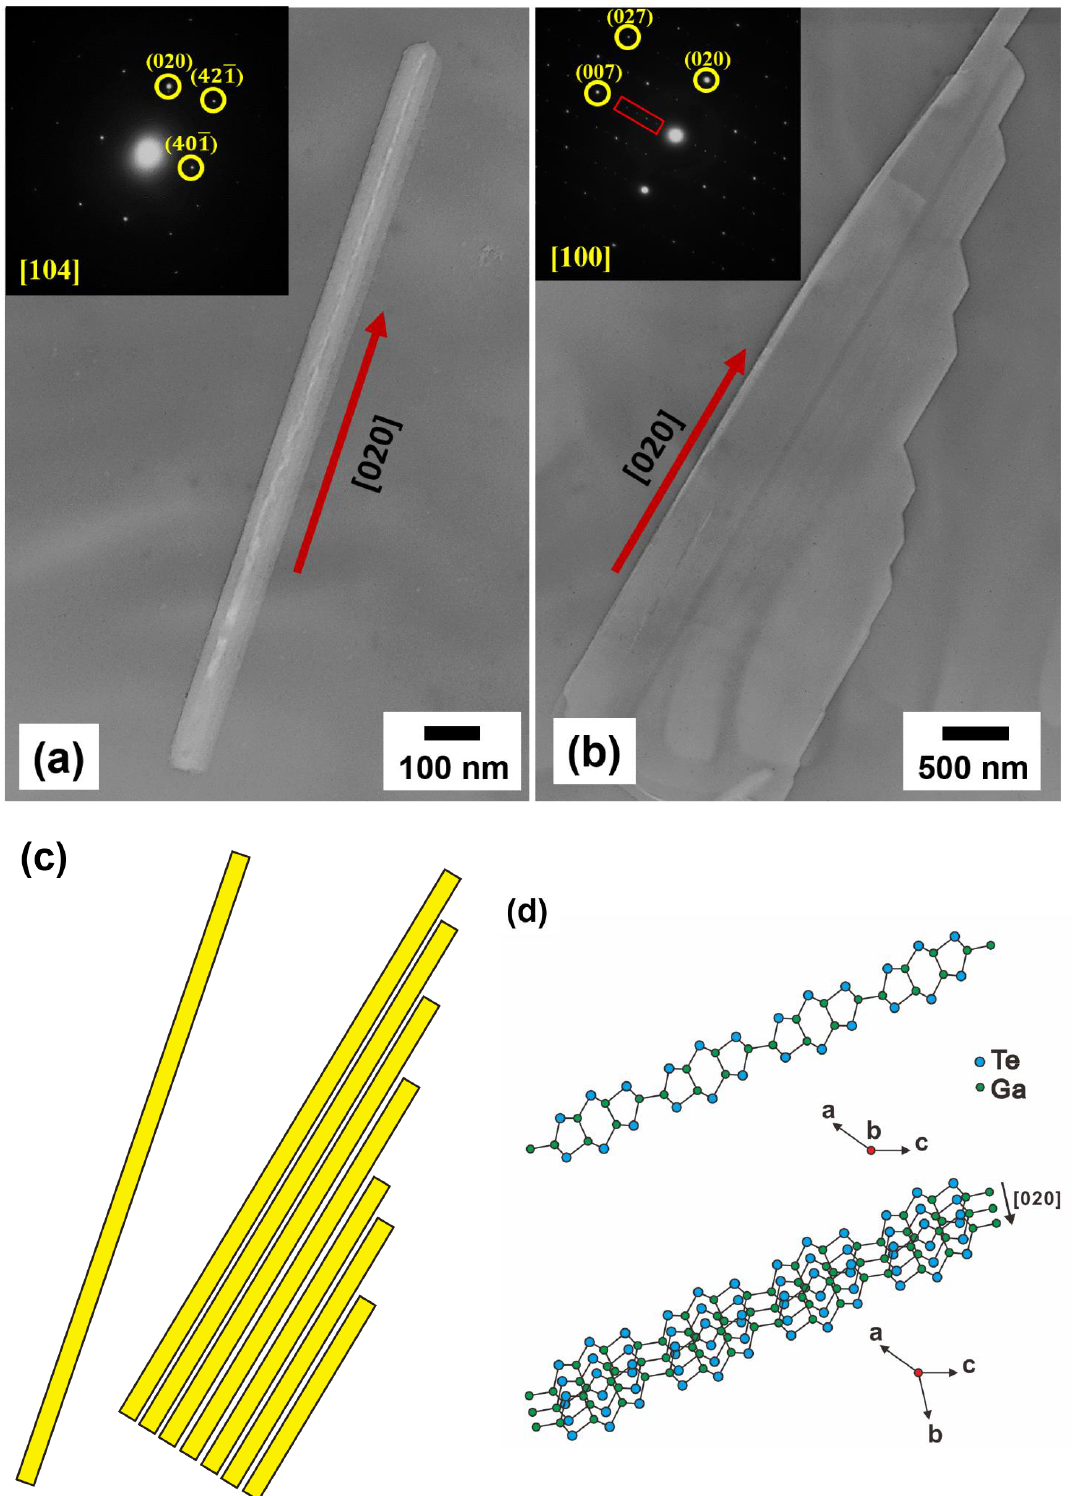
Figure 4. ( a ) TEM image of single GaTe nanowire. Inset shows selected area electron diffraction (SAED) patterns revealing its single-crystalline monoclinic structure and a [020] growth direction. ( b ) TEM image of single GaTe nanosheet. Inset shows SAED patterns with extra spots along the short axis of nanosheets. ( c ) Schematic illustration of assembling GaTe nanowires into nanosheets. ( d ) Schematic illustration of single GaTe layer stacking into GaTe nanowire along the b-axis.